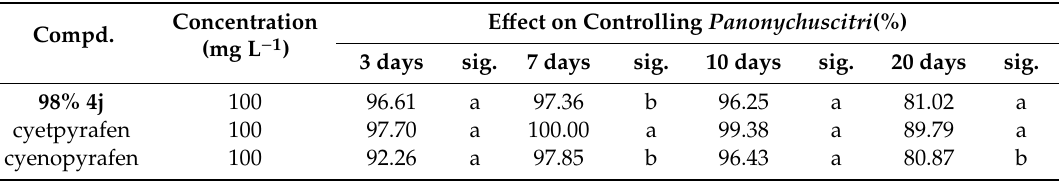
Table 5. Acaricidal activity of the compound 4j against P. Citri in field tests (Nanning, China).